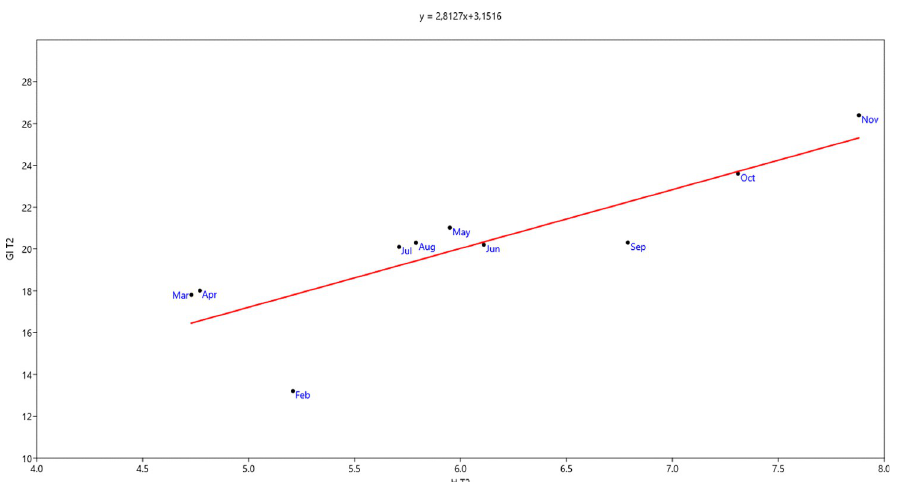
Fig 6. Relationship between growth index and plant height in Aizoaceae mixture.